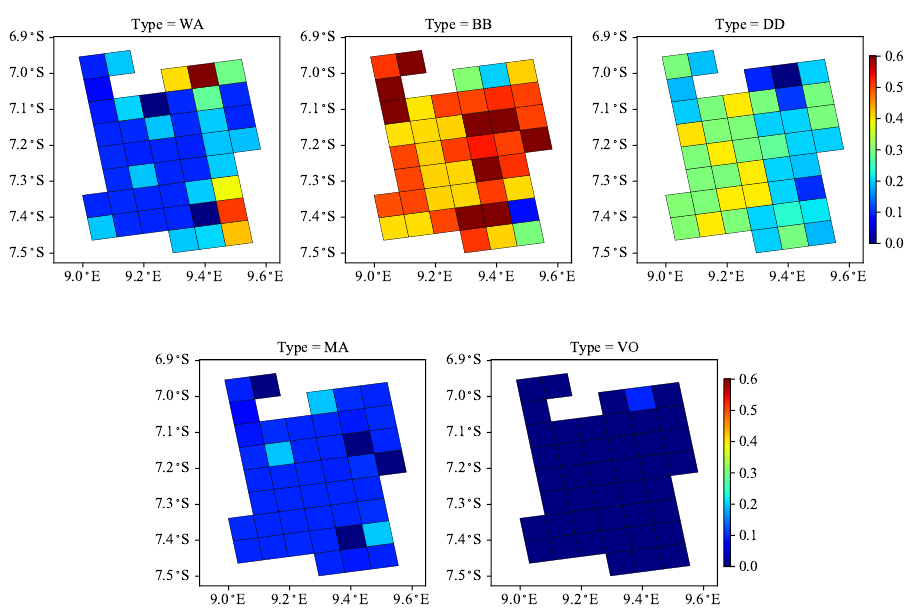
Figure 11. The sum of the first 10 best aerosol model evidences for each aerosol type from Set 2. The TROPOMI spectra were recorded on 4 July 2019.